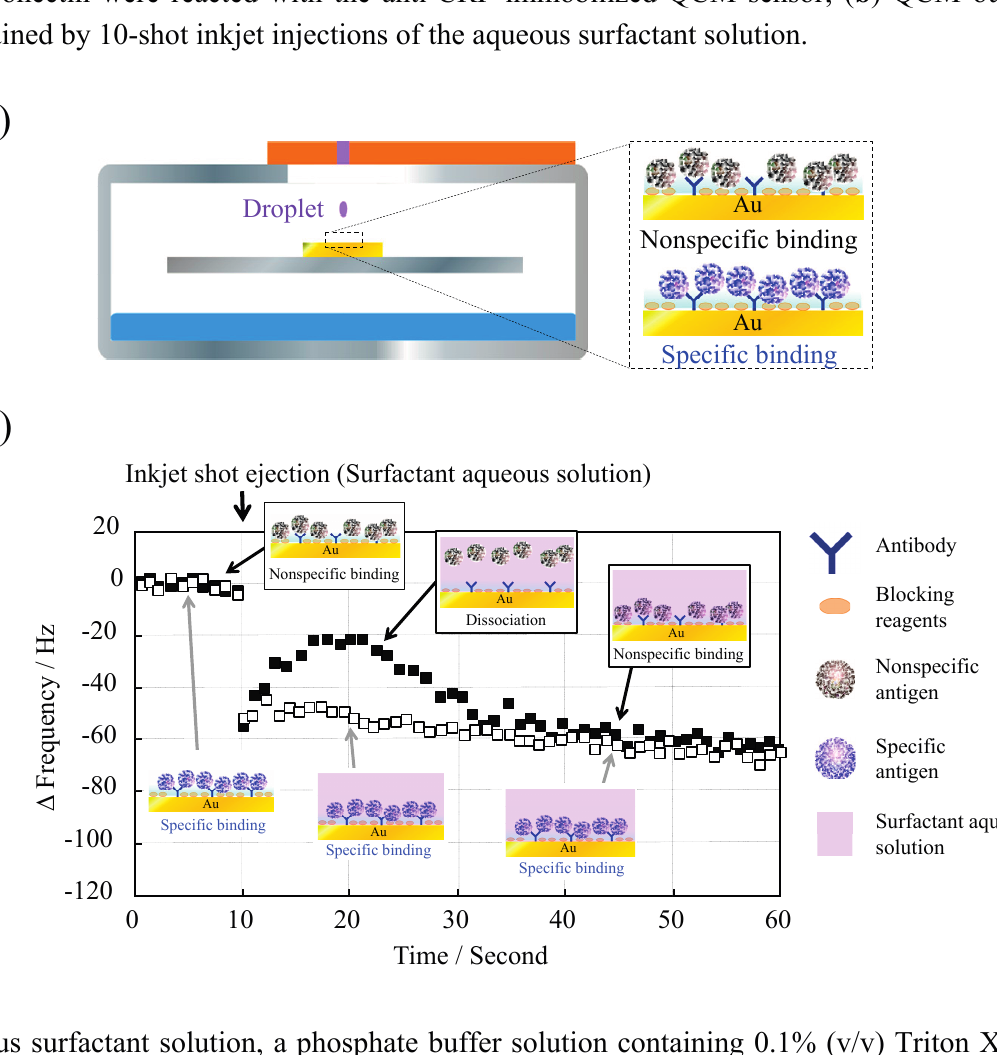
Figure 4. Discrimination of nonspecific binding from specific binding: ( a ) CRP and adiponectin were reacted with the anti-CRP immobilized QCM sensor; ( b ) QCM output obtained by 10-shot inkjet injections of the aqueous surfactant